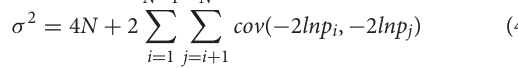
( Table S4 ), including 7 signaling molecules, namely brain derived neurotrophic factor (BDNF), insulin like growth factor 1 (IGF- 1), interleukin (IL)-1 β , IL-6, IL-4 tumor necrosis factor (TNF) α , CD200, and vascular endothelial growth factor A